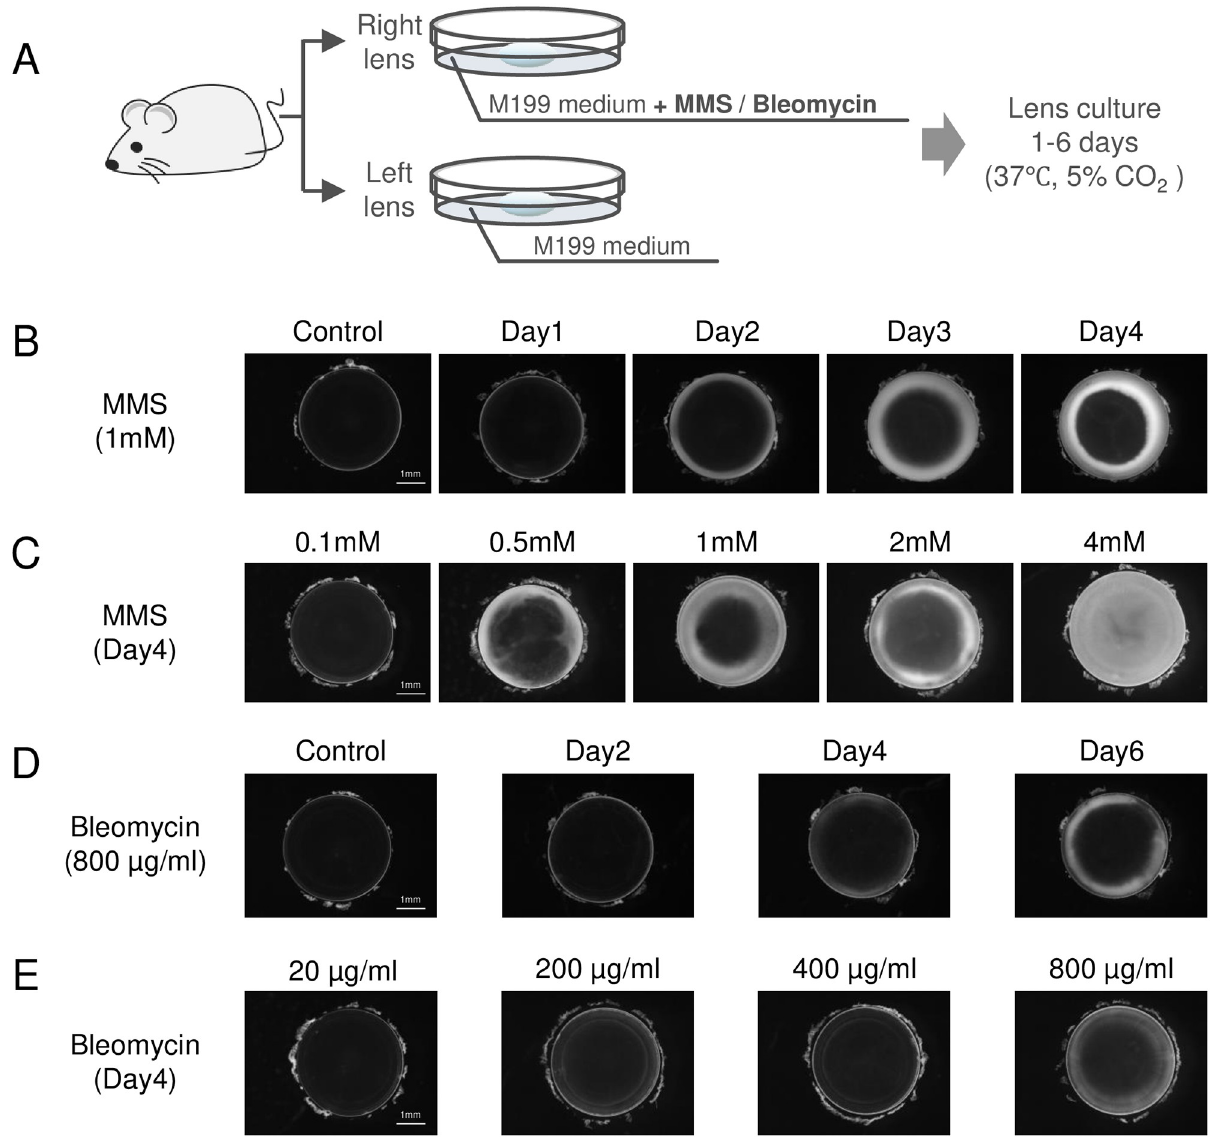
Fig 1. MMS and Bleomycin induce rat lens opacity in time- and concentration-dependent manners. (A) Schematic of the ex vivo experimental system used to induce opacity in rat lenses with MMS or Bleomycin treatment. Lenses were enucleated from 6-week-old male Sprague Dawley rats and cultured for 1–6 days. From each individual animal, one lens was cultured in medium containing MMS or Bleomycin, and the lens of the contralateral eye was cultured in vehicle control medium. (B) Opacity induced by incubation of lenses in medium containing MMS (1 mM) for 1–4 days. Control lenses were cultured in medium without MMS for 4 days. (C) Opacity induced by culture of lenses in medium containing 0.1–4 mM MMS for 4 days. (D) Opacity induced by incubation of lenses in medium containing Bleomycin (800 μ g/mL) for 2–6 days. Control lenses were cultured in medium without Bleomycin for 4 days. (E) Opacity induced by culture of lenses in medium containing 20–800 μ g/mL Bleomycin for 4 days. https://doi.org/10.1371/journal.pone.0273456.g001 clustered close to one another (Fig 3A). The control was clustered farthest away from the other treatment groups. In the PCA plot, the samples were plotted at increasing distances away from the control group. The distances increased progressively in ascending order as follows: MMS Day 2, Bleomycin Day 2, MMS Day 4, and Bleomycin Day 6 (Fig 3B). The difference in incu- bation time affected the expression profiles more strongly than did the difference in drug treat- ments between MMS and Bleomycin. These findings suggest that MMS and Bleomycin have